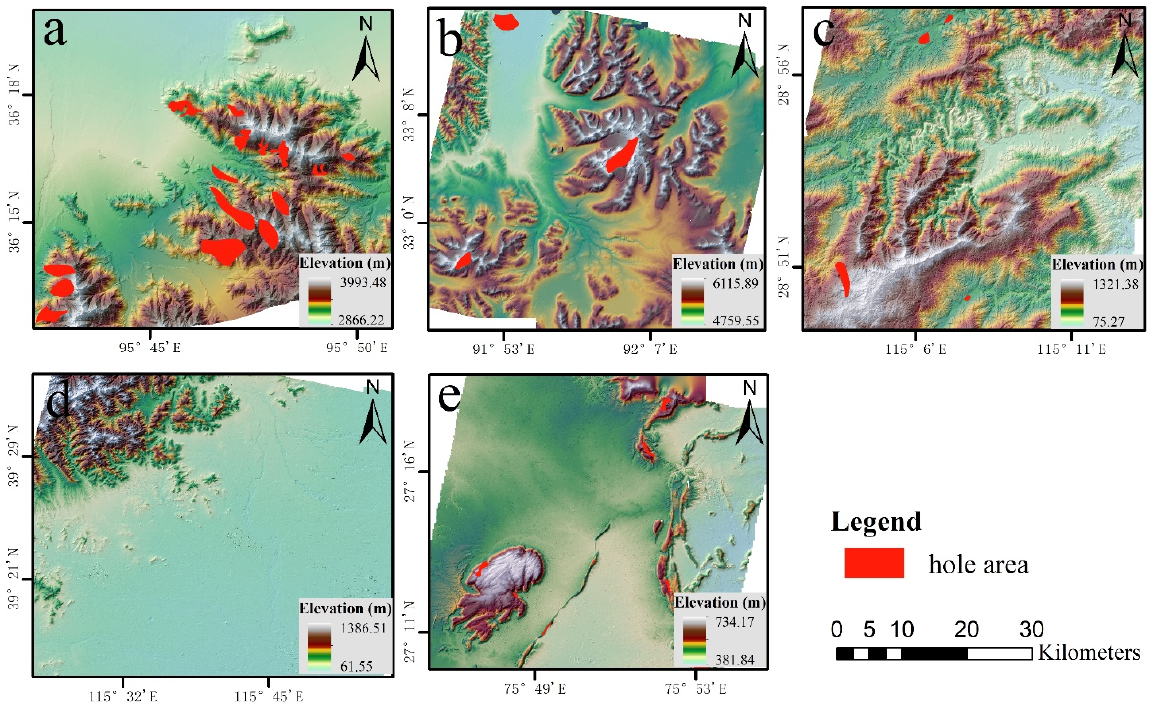
Figure 7. SGM algorithm to extract DSM: ( a )-WV2_DSM, ( b )-ZY3_DSM, ( c )-GF7_DSM, ( d )-